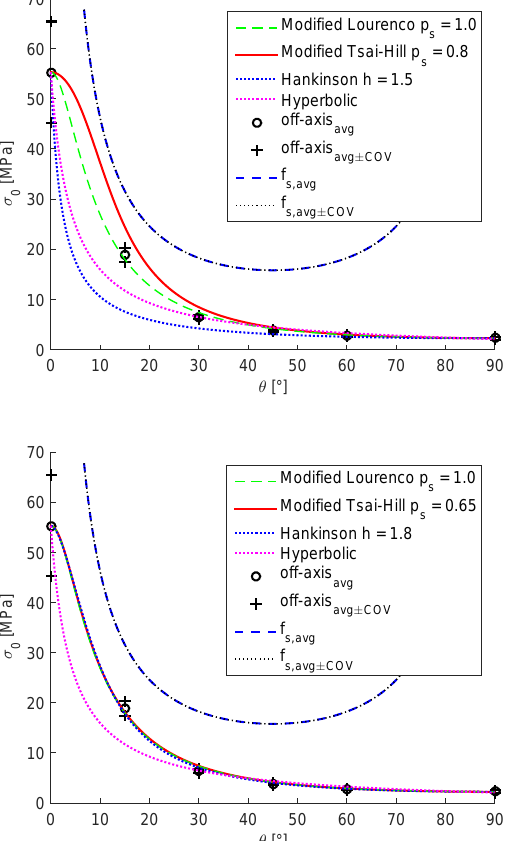
Figure 3. The experimental data of Douglas fir [18] with uncalibrated (top) and calibrated (bottom) failure conditions.